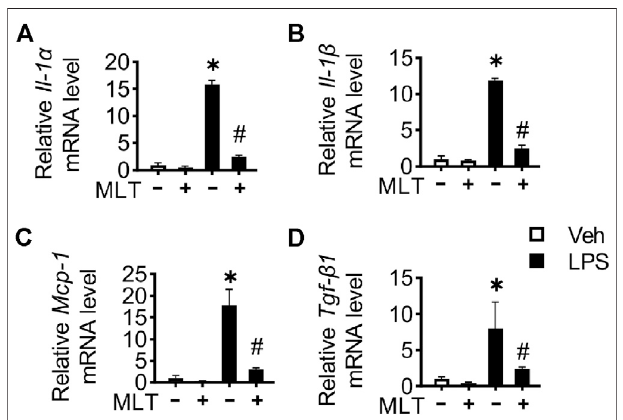
FIGURE4| Melatoninrelievesin fl ammationinHK-2cellstreatedwithLPS. HK-2 cell in fl ammatory cytokine Il-1 α (A) , Il-1 β (B) , Mcp-1 (C) , and Tgf- β 1 (D) mRNA levels are measured using RT-PCR (* vs. Veh, p < 0.05; # vs. LPS, p <